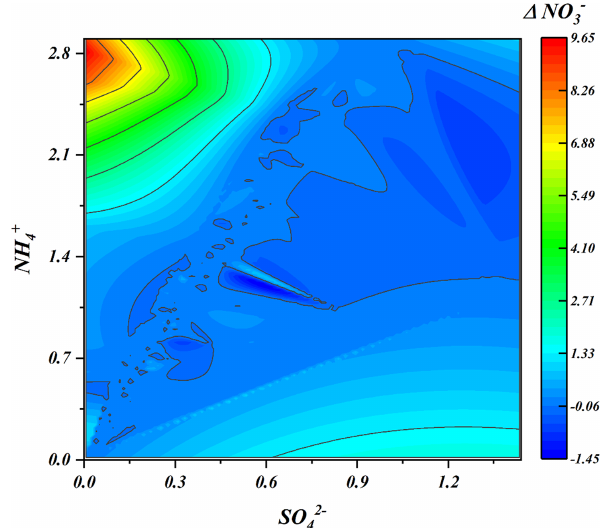
Figure 7. Direct observations of nitrate production facilitated by initially generated sulfate. (All data were matrixed to avoid interfer- ence caused by